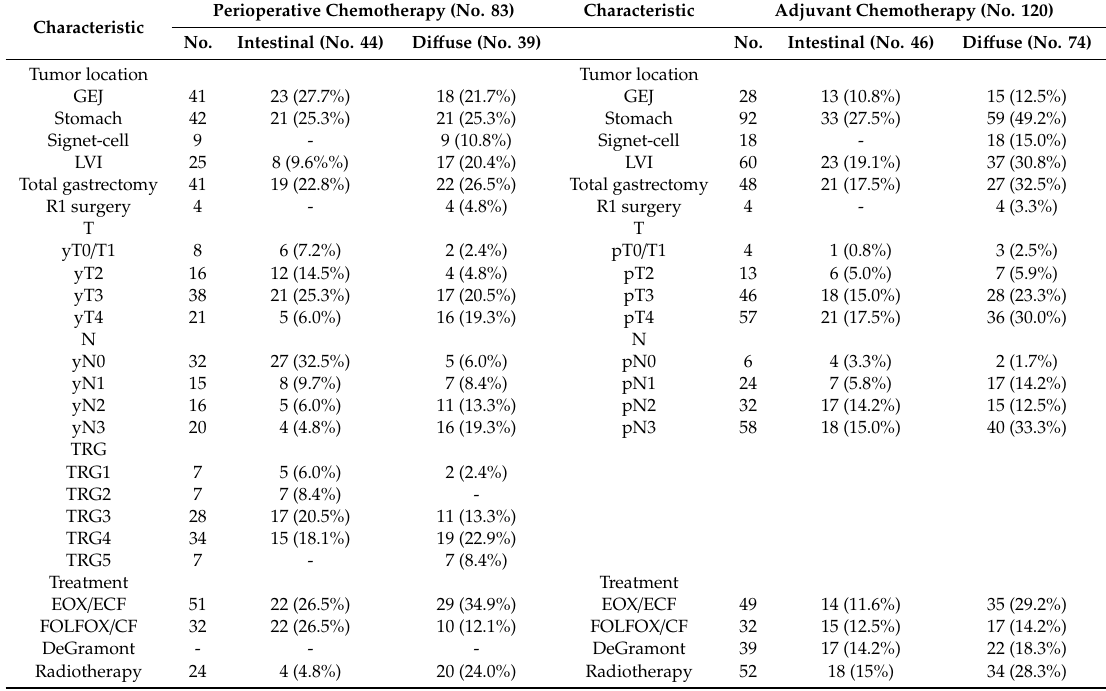
Table 1. Patients’